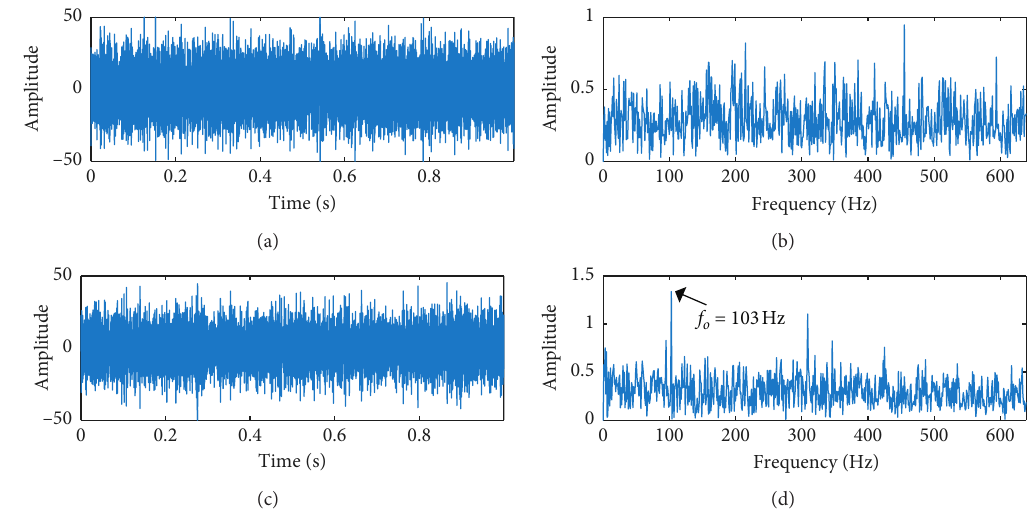
Figure 19: Results of the experimental signal in Figure 14(a) by different methods: (a) optimal mode extracted by the fixed-parameter VMD and (b) its envelope spectrum; (c) optimal mode extracted by PSO-based VMD and (d) its envelope